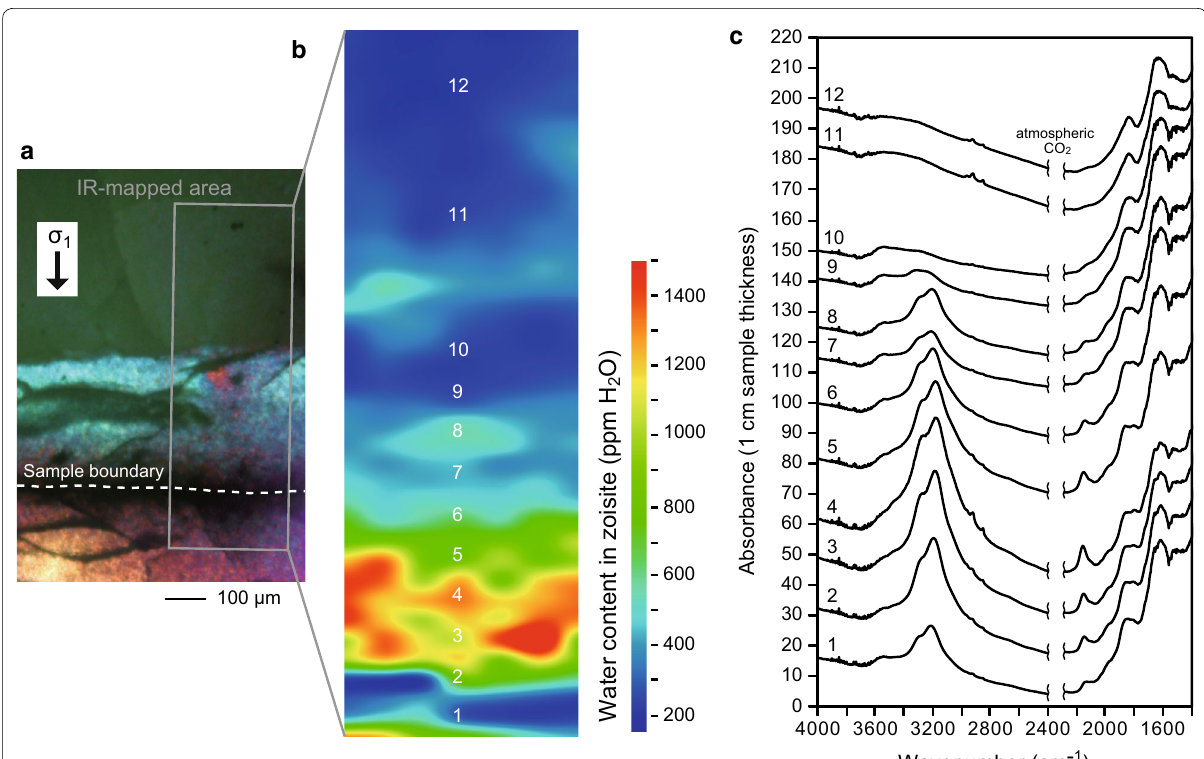
Fig. 9 IR mapping results for the upper and lower sample boundaries of the water‑added experiment. a Optical image (cross‑polarized light with a gypsum plate). The compression direction ( σ 1 ) is shown by an arrow. The upper and lower sample boundaries are shown as white dashed lines. The IR‑mapped area is shown as a gray rectangle. b IR mapping results shown as water contents in zoisite. c Raw IR spectra selected from ( b ). The numbers correspond to the parts in ( b ). The IR spectrum for the sample boundary corresponds to the No. 4 spectrum, and the calculated water content was 1500 ppm H 2